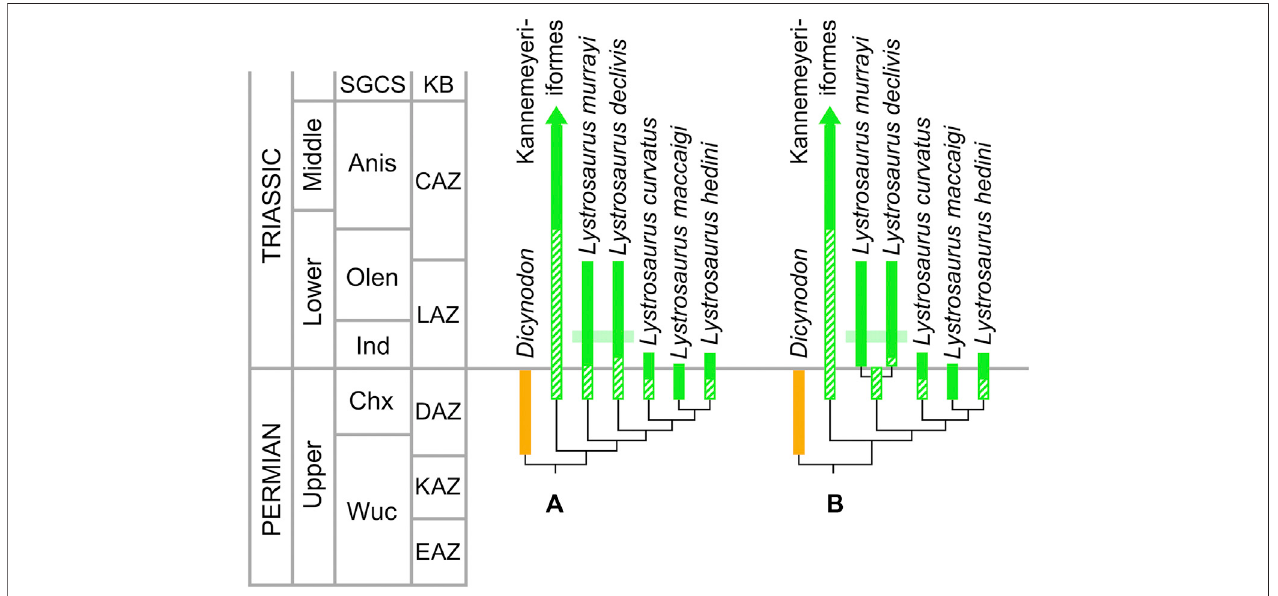
FIGURE 2 | Lystrosaurid diversity across the Permo-Triassic boundary with stratigraphic data from Botha and Smith (2006), Smith and Botha-Brink (2014), Botha et al.(2019), Smith et al.(2020), and Viglietti et al. (2020), based on the leading treetopologies for thegenus Lystrosaurus . (A) Topology 1in which Lystrosaurusmurrayi and L . declivus form a grade (e.g. Kammerer et al., 2013; Kammerer and Smith 2017;Cox and Angielczyk,2015). (B) Topology 2 inwhich L. murrayi and L . declivus are sister taxa (Kammerer, 2019a; Kammerer, 2019b; Kammerer et al., 2019; Olroyd et al., 2017). Dicynodon and Kannemeyeriiformes are outgroups. Stratigraphic ranges of survivor/recovery taxa in medium green and extinction taxa in orange. Thick bars are known stratigraphic ranges; ghost lineages and ghost taxa are indicated bydiagonal hatching; relationshipsindicatedbythinblackbranches.Lightgreen fi eldrepresents “ Lystrosaurus abundantzone ” ofBothaand Smith(2006).Lystrosaurid tree topologies from Angielczyk et al. (2013), Kammerer and Smith (2017), Kammerer (2019a), Kammerer (2019b), and Kammerer et al. (2019). Abbreviations: Anis, Anisian; CAZ, Cynognathus Assemblage Zone; Chx, Changhsingian; DAZ, Daptocephalus Assemblage Zone; EAZ, Endothiodon Assemblage Zone; Ind, Induan; KAZ, Cistecephalus Assemblage Zone; KB, Karoo biozones; LAZ, Lystrosaurus declivis Assemblage Zone; Olen, Olenekian; Wuc,